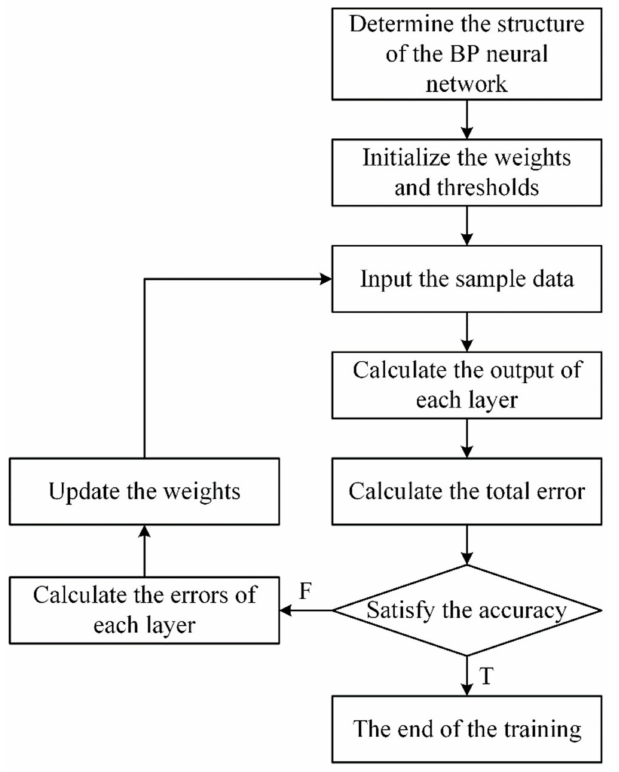
Figure 1. Flowchart of the BP neural